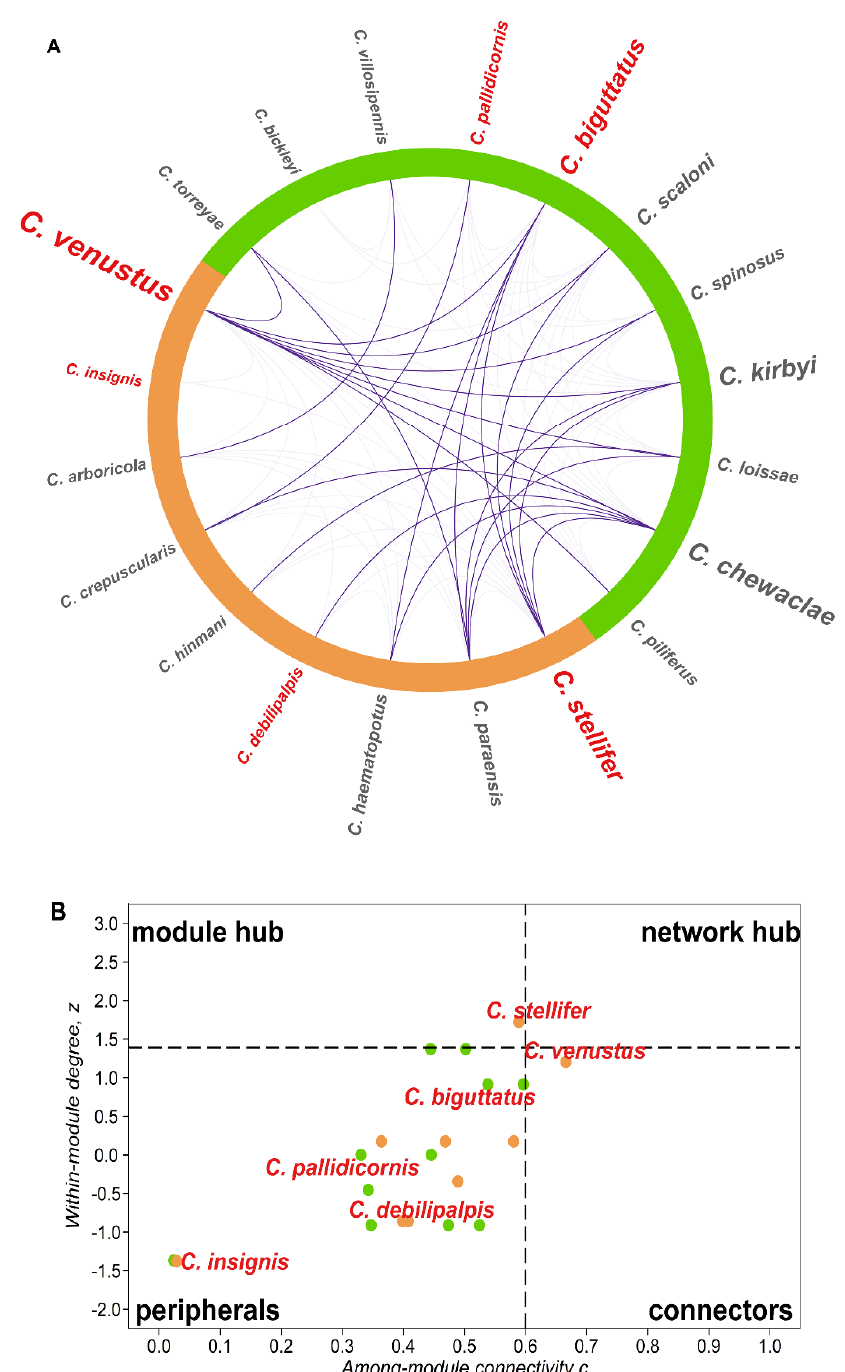
Figure 6. Co-occurrence Culicoides network highlights seasonal compartments connected by vector species: weekly co-occurrence circular network maps and species roles. ( A ) Circular network: species are arranged in the two modules nesting seasons occurrence (Figure S1.4; summer–fall: orange; winter–spring: blue). Co-occurrence interactions between modules are drawn by a stronger opaque links pattern (violet) than within module interactions (transparent violet). Label size is relative to species degree (Table S1.4); vectors are red printed and plotted with circleplot [108]. ( B ) Species roles in the co-occurrence network sustaining and connecting modular configuration are shown in dimensions defined by z (within-module degree) and c (among-module connectivity) scores (Table S1.4). Dot colors follow modules in A , but only vector species are labeled. Dashed lines: threshold value for z (horizontal line: 1.39) and for c (vertical line: